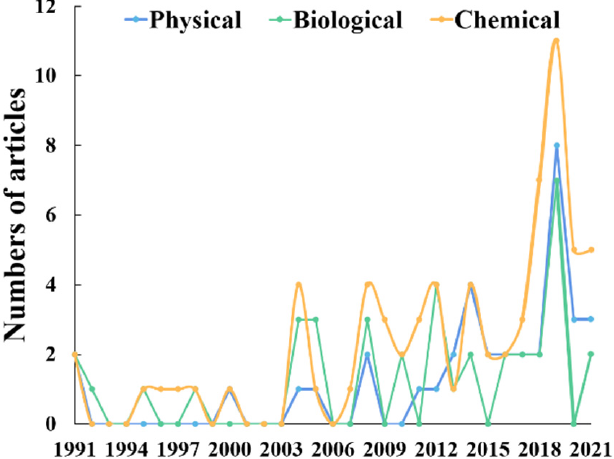
Figure 3. Research articles on emitter clogging of drip irrigation published in 1991–2021. Hence, the aims of this review were to (1) summarize the types and research progress of emitter clogging; (2) discuss the inducement, mechanism, as well as control methods for the chemical clogging of emitters caused by saline water and fertilizers; (3) raise a systematic solution to solve the chemical clogging of emitters; and (4) ascertain the current challenges and technical trends of emitter clogging caused by various water sources and